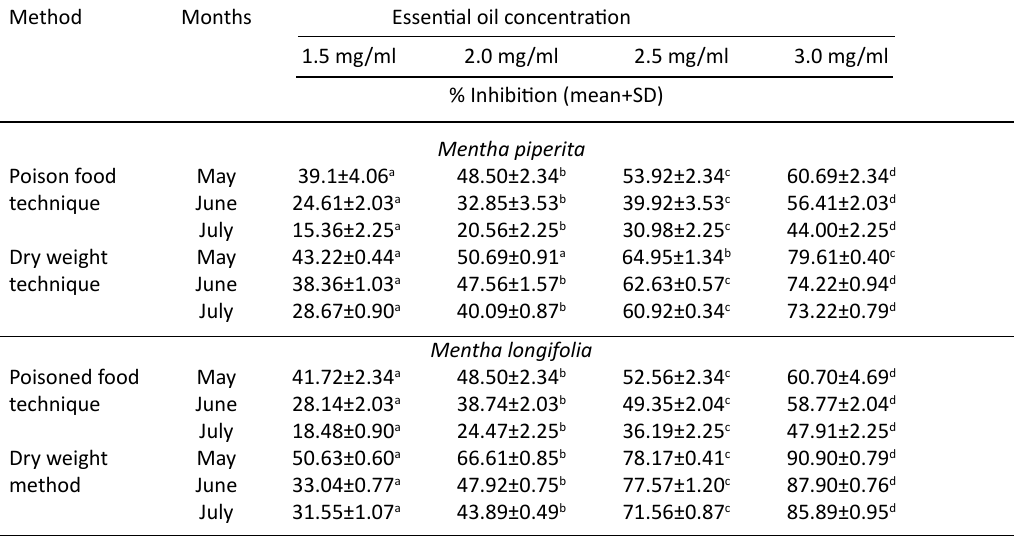
Table 6. Antifungal activity of essential oil of leaves of M. piperita and M. longifolia against F. oxysporum Method